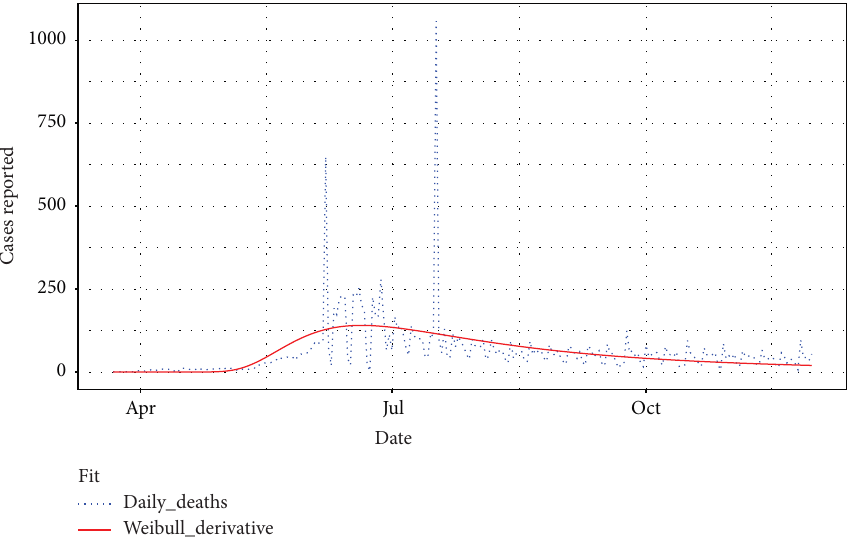
Figure 13: Fit of the frst derivative of the Weibull curve (in red) to the number of daily deaths (in blue) from COVID-19 in Chile (using data from March 22 to November 30,